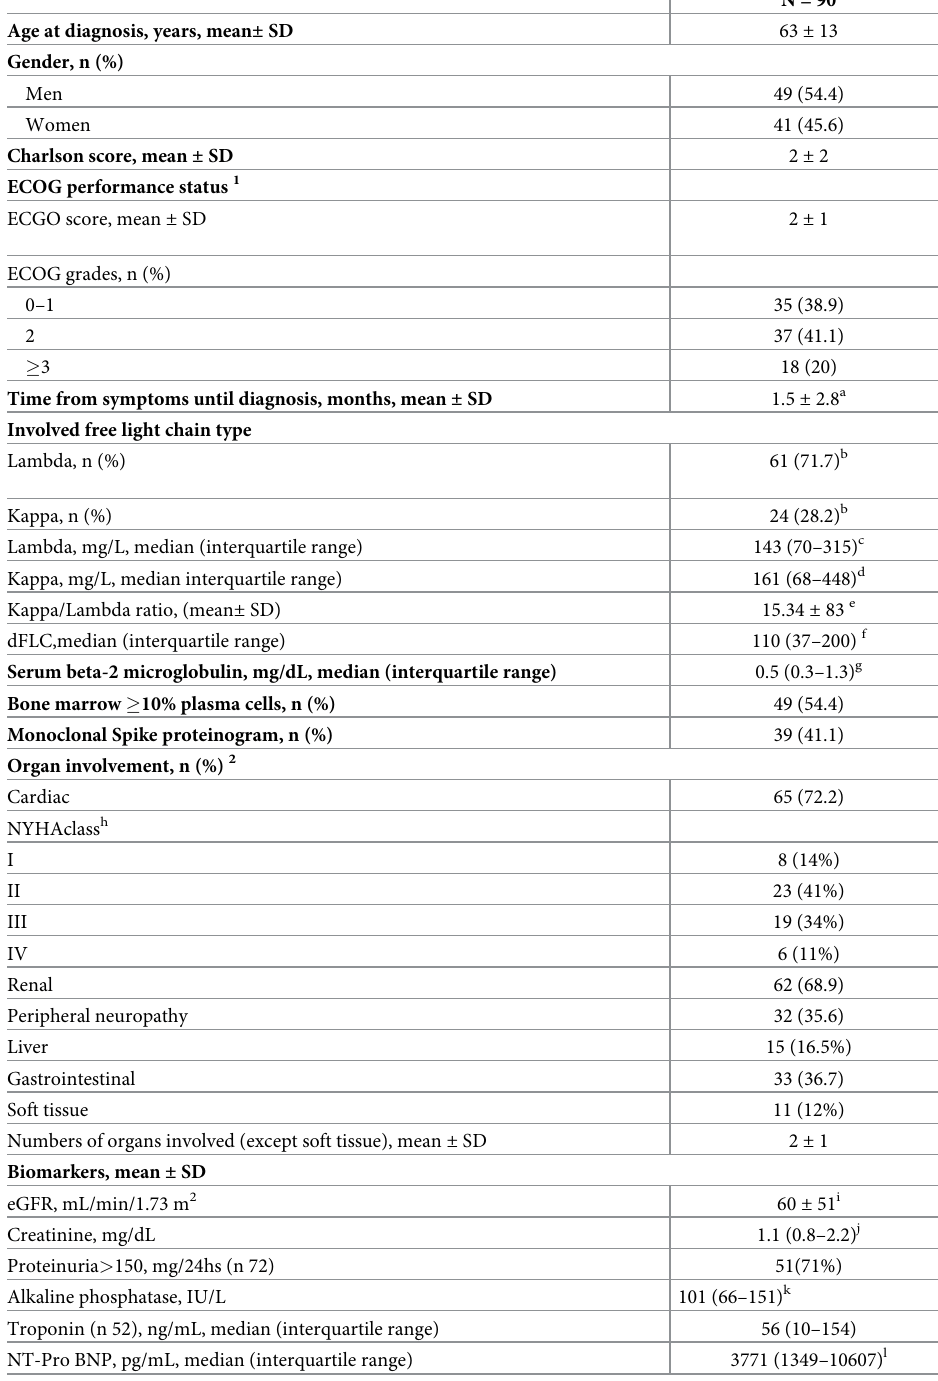
Table 1. Baseline characteristics of AL amyloidosis